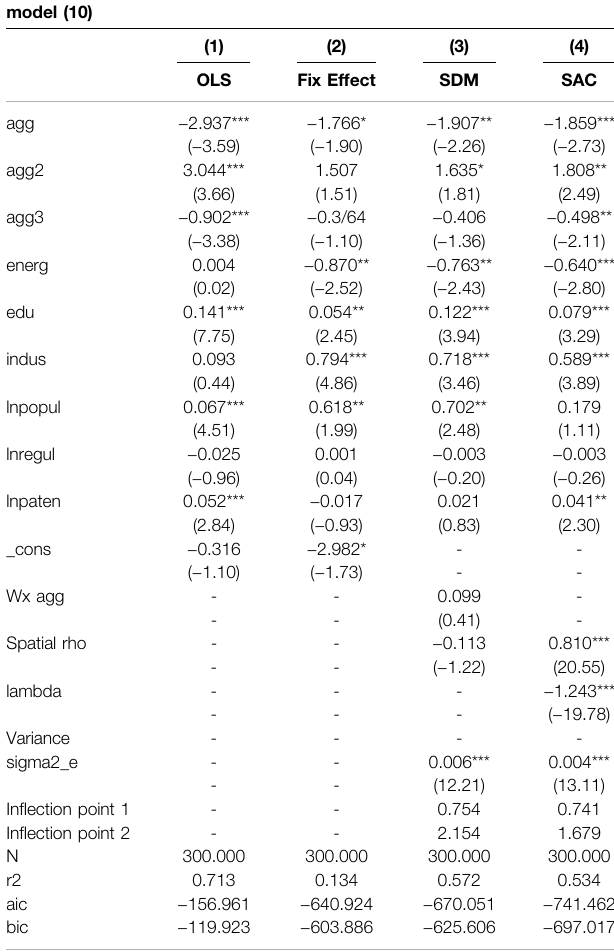
TABLE 8 | Regression results of non-spatial OLS model, non-spatial fi xed effect panel model, SDM model, and SAC